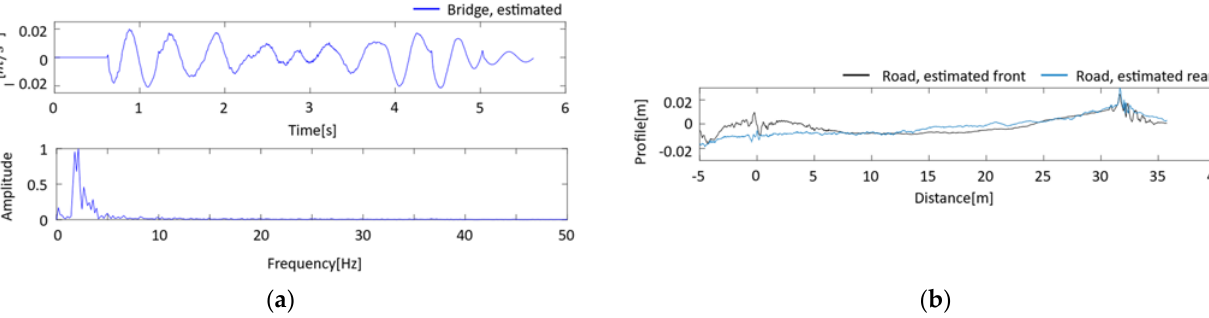
Figure 10. Comparison of estimated and measured PSD functions of road unevenness. Table 5. The estimated mechanical parameters of vehicle and bridge. Parameter